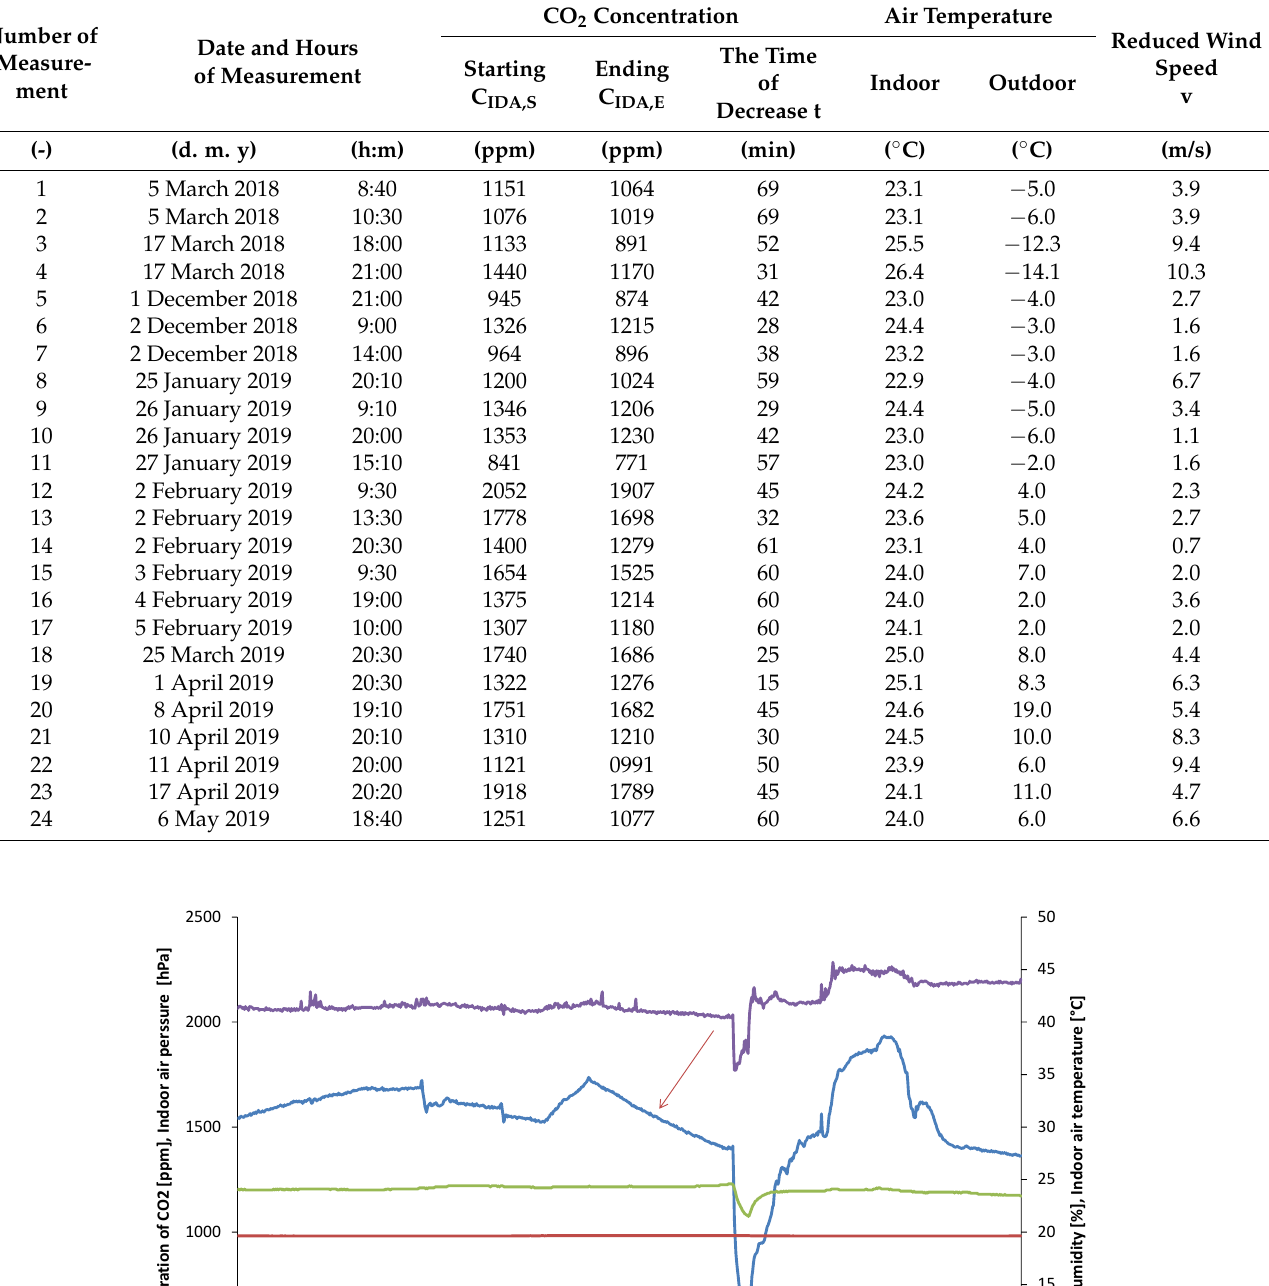
Table 1. External and internal parameters in selected days and hours.